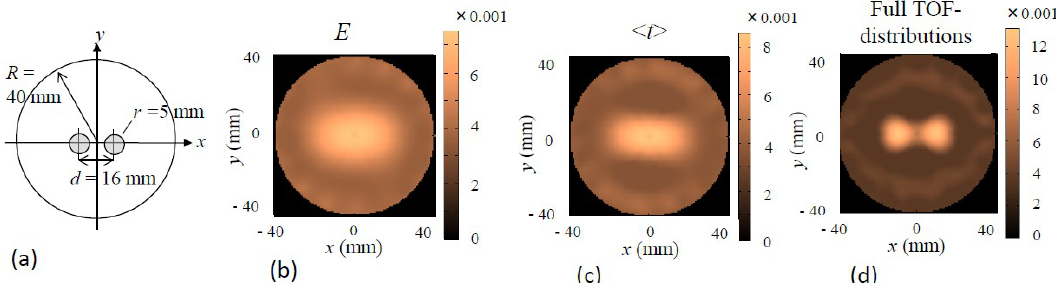
Figure 16. Effects of the type of featured data on the quality of the reconstructed DOT images of μ a . ( a ) Geometry of a 2D object; reconstructed DOT images using ( b ) E (CW), ( c ) < t >, and ( d ) full TOF-distributions normalized by E . The 2D object has a diameter of 80 mm and contains two small absorbers with a diameter of 10 mm and a separation of 16 mm. Modified from Reference [171].